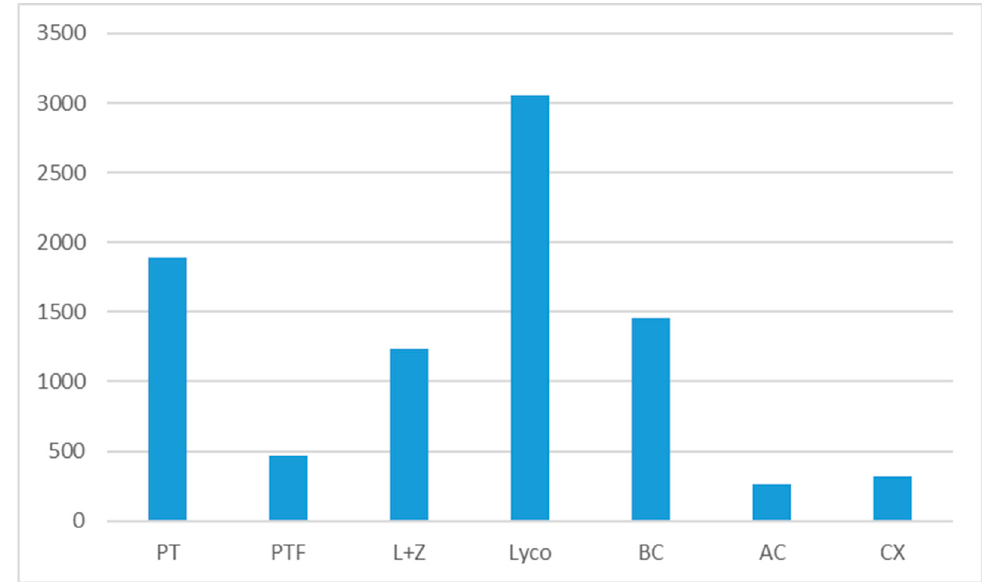
Figure 3. Carotenoids dietary intake in Spanish population (µg/p/day). Lutein plus zeaxanthin (L + Z) and lycopene (Lyco) from [37]. β -carotene (BC), α -carotene (AC) and β -cryptoxanthin (CX) from [36].